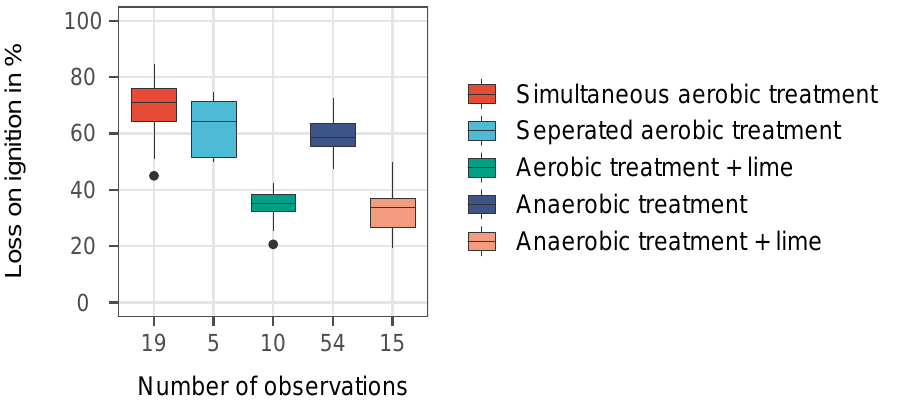
Figure 3. Loss on ignition (LOI) in percent as a function of the primary sludge stabilization method. Statistical values are provided in Table S4.